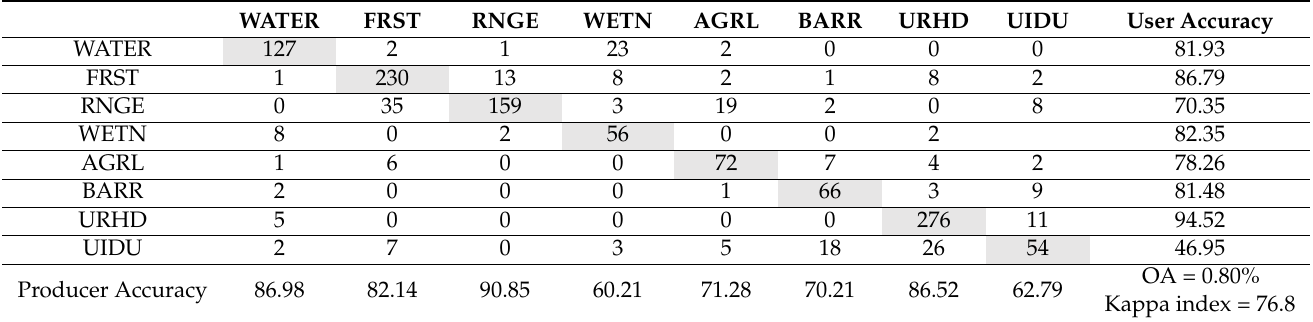
Table 5. Accuracy assessment for supervised classification of Sentinel image